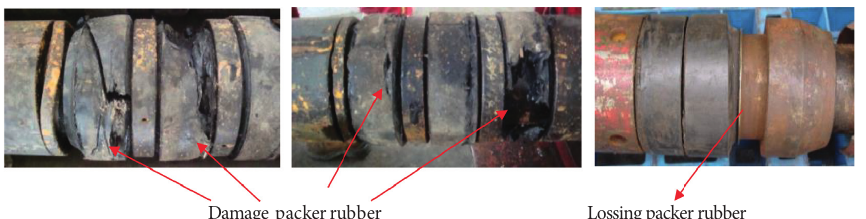
Figure 2: Failure cases of the rubber